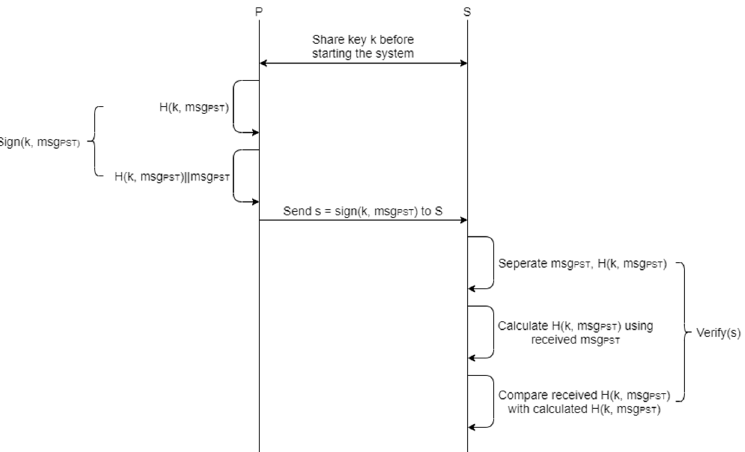
Figure 9. Proposed signature procedures.